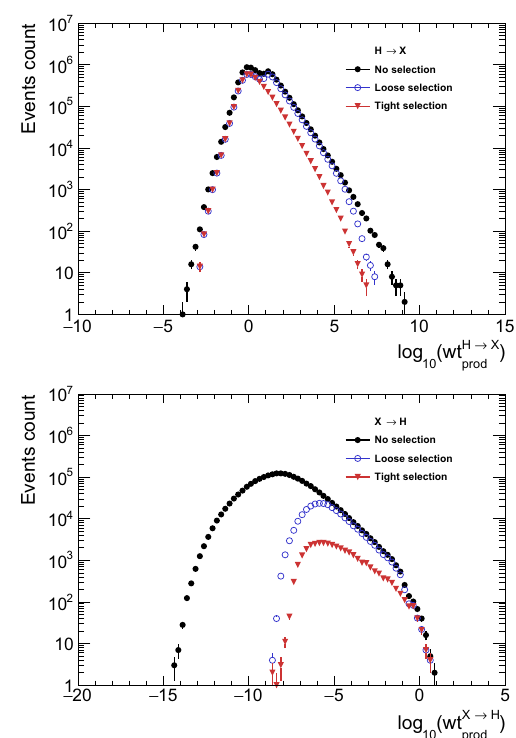
Fig. 2 Weight distribution for H sample re-weighted to X (top panel) and for the X sample re-weighted to H (bottom panel). If the distribu- tion featured a long tail extending to high weights, it would indicate a problem with re-weighting in regions of the phase space where the ratio of the matrix element (B) with respect to the one of the original sample (A) is too large in comparison with the typical